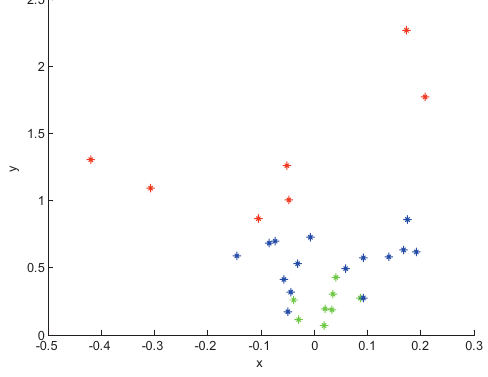
Fig. 8. Centers generated after 90 modules presented